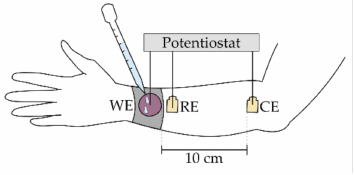
Figure 4. Measurement setup on human forearm (Series I) with the textile electrode indicated in pink and the conventional electrodes indicated in yellow.